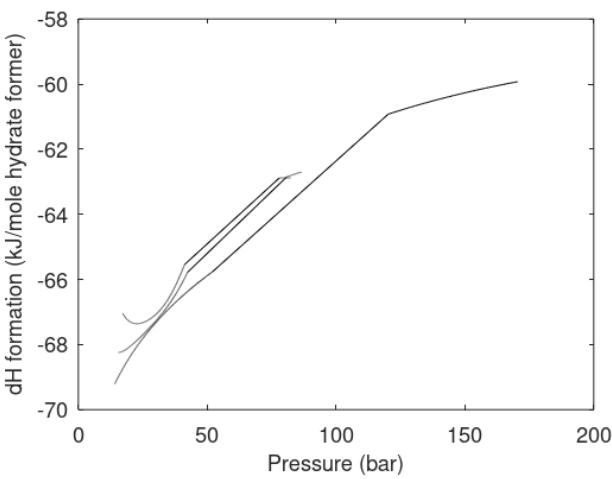
Figure 9. Enthalpies of hydrate formation in kJ/mol hydrate former as function of pressure. The bottom solid curve is pure CO 2 hydrate; the middle one is 10 mol % N 2 in the CO 2 /N 2 mix; the top solid curve is for 20 mol % N 2 .